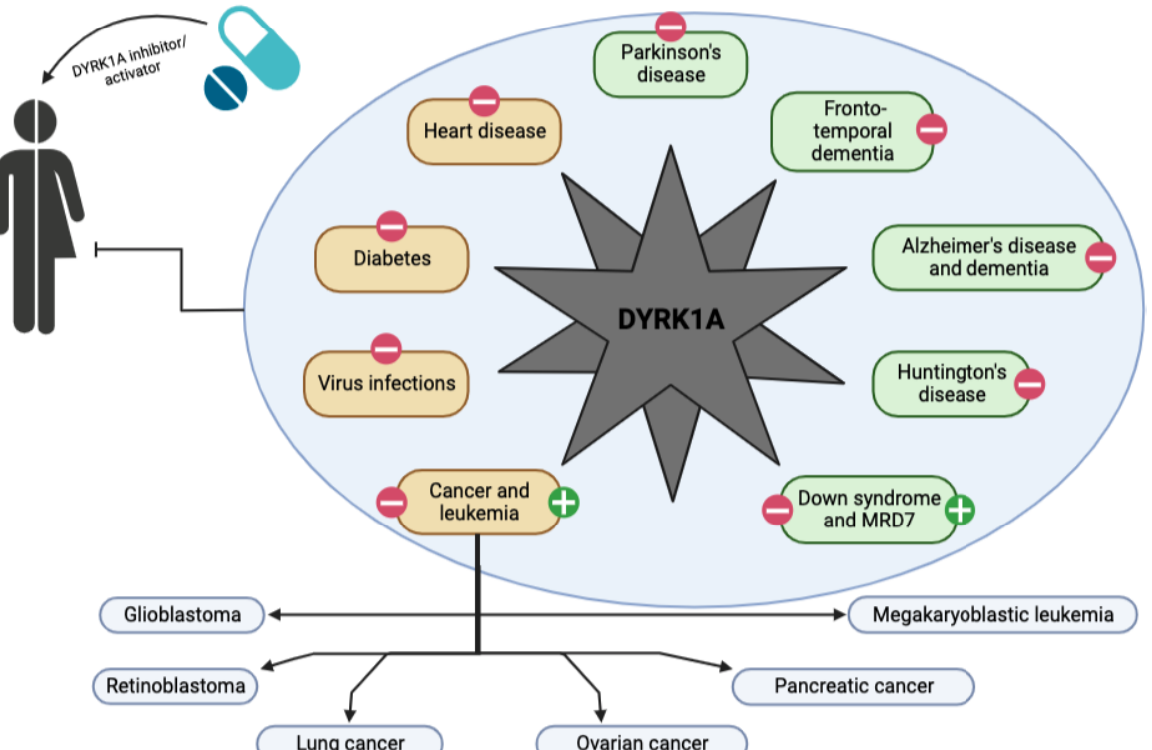
Figure 3. Schematic representation of the spectrum of action of a DYRK1A activator or inhibitor on the development of neurological (in green) and other diseases (in brown) in humans. Pathologies are labeled with a green cross if DYRK1A activation is a potential therapeutic solution and with a red line if DYRK1A inhibition is a potential solution.